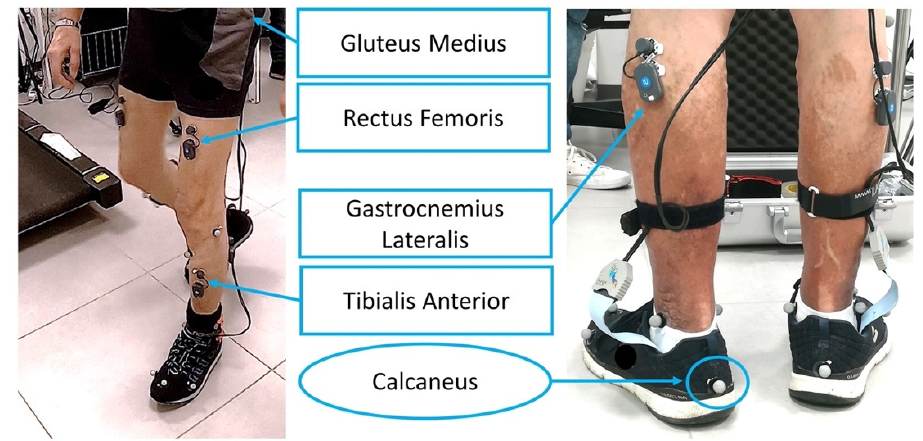
Figure 1. Example of acquisition set up.